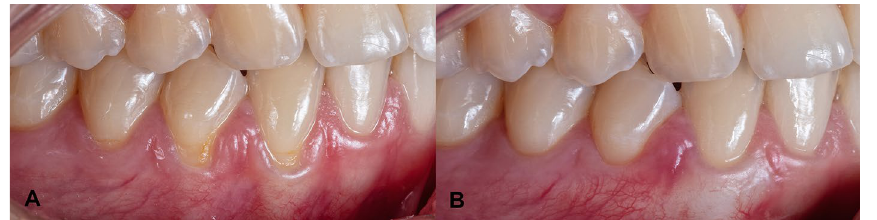
Figure 2. ( A ) Baseline, ( B ) 6 months